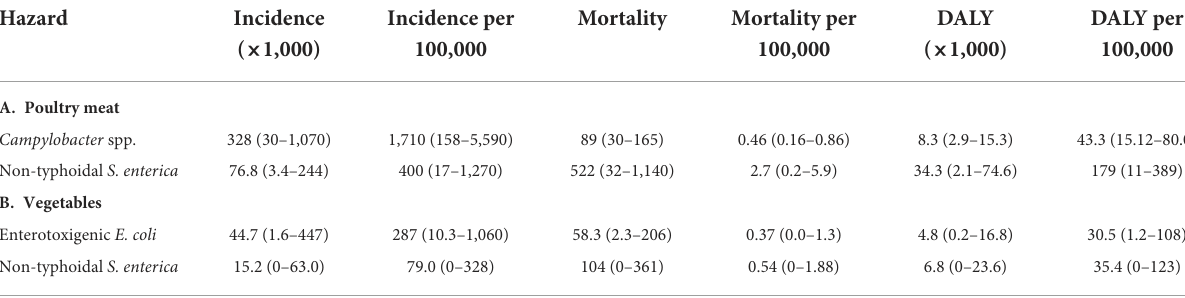
TABLE 5 Disease burden associated with specific food consumption in Burkina Faso in 2017 (total population).